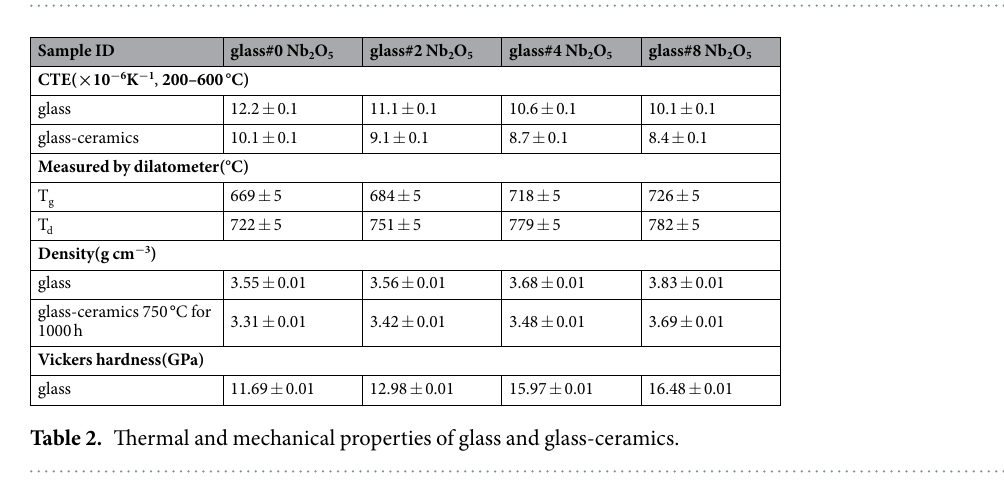
Figure 6a shows the XRD patterns of glass-GDC powder couples held at 750 °C for 1000 h in air. The main phase in the glass and GDC reaction couples (50:50 w/w) is Ce 0.8 Gd 0.2 O 1.9 . This implies that the glass is chemically compatible with the GDC electrolyte. On the other hand, there is observation of cation interdiffusion at the glass/ GDC interface. Figure 6b to d show the micrographs and EDS line scans of the glass/GDC sealing couples held at